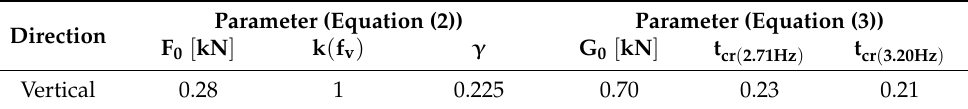
Table 11. The human-induced dynamic load. Equation (2) (walking) and Equation (5) (running) parameter values. Parameter (Equation (2)) Parameter (Equation (3)) Direction